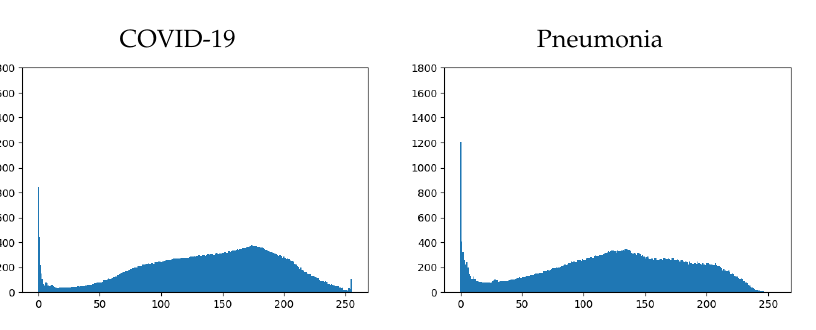
Figure 4. Image example from each class (after pre-processing) with its histograms. In order to more clearly detect the characteristics of each class, a similar study must be carried out with all the images in the dataset. To achieve this goal, as we know that the relevant information could be concentrated in the histograms, the mean histograms of each class are calculated. These mean histograms show the mean of the occurrences of each value on the grayscale for each class and are presented in Figure 5.